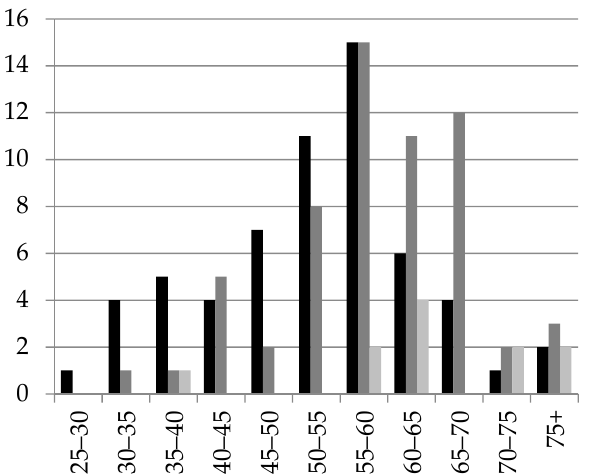
Figure 2. Ages of patients at the time malignant tumors were first detected.